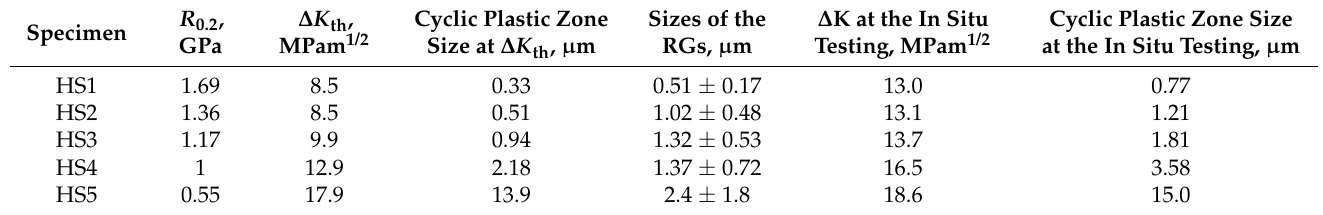
Table 2. The cyclic plastic zone sizes of all the specimens at ∆ K th and the sites of the in situ